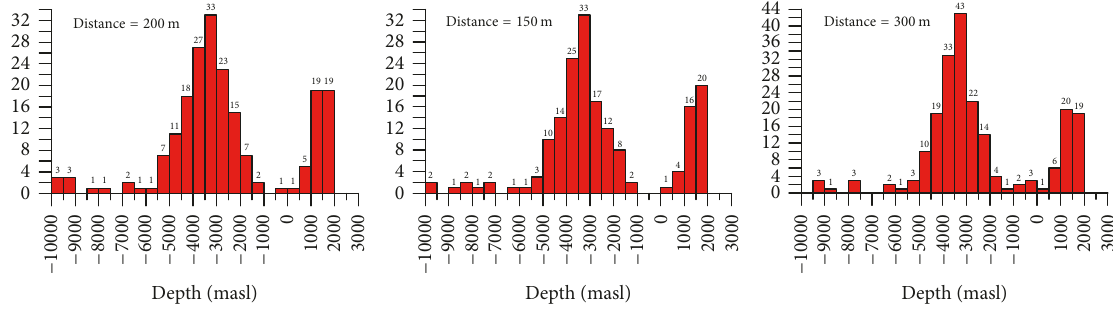
Figure 34: Histograms of the Frac-Digger sensitivity of the estimated depths of dikes to the distance from the event to the plane ( 𝛿𝑍 ).